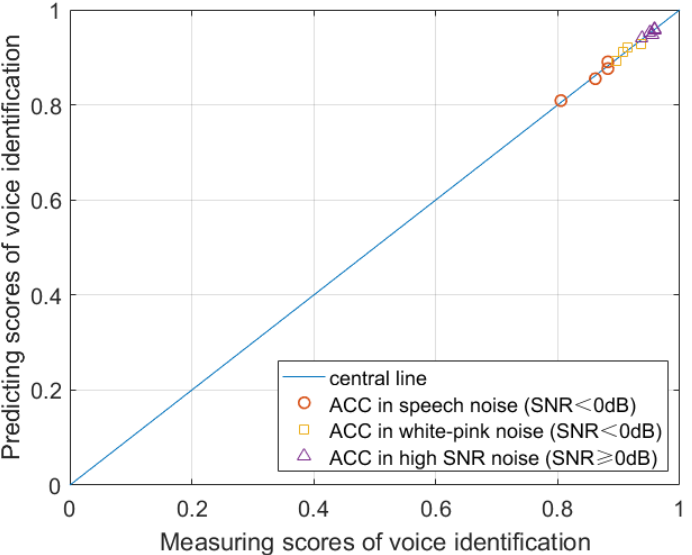
Figure 4. Scatter diagram of measured and predicted values of voice identity perception.